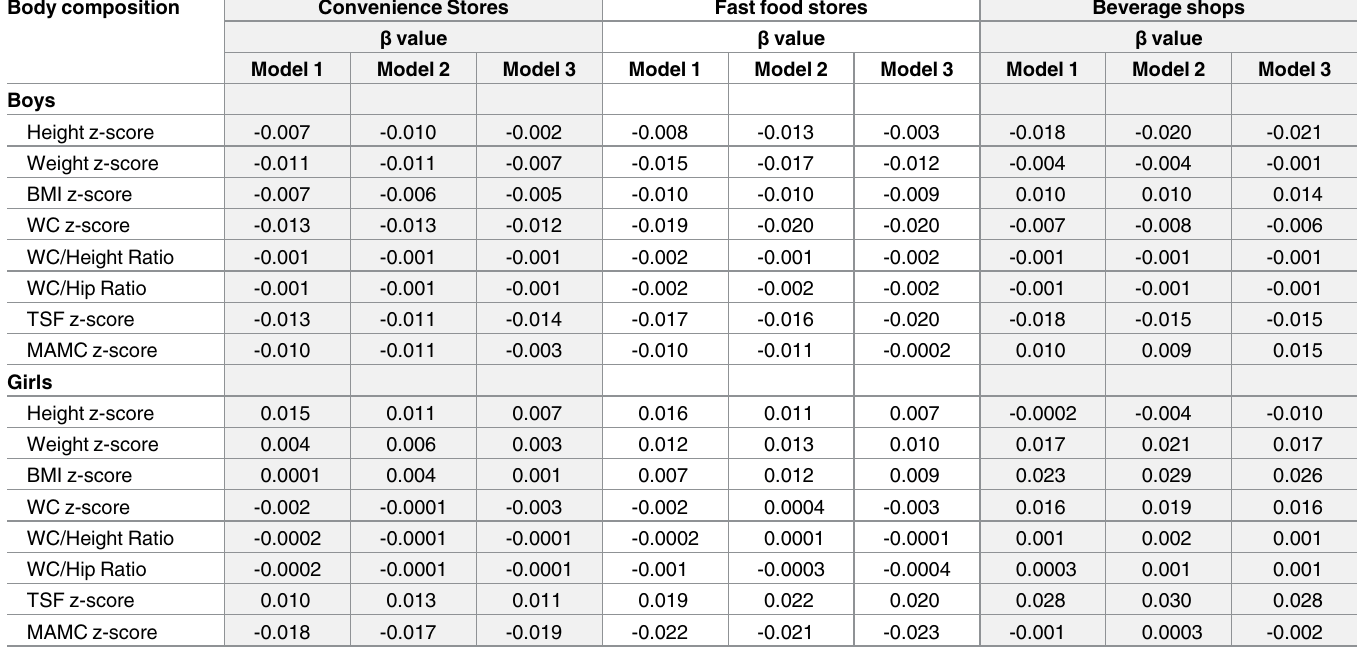
Table 3. Multiple linear regressions for body composition in relation to the food environments within 1000m a around junior high school by gender.